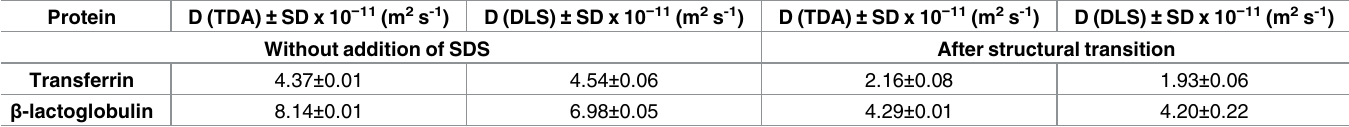
Table 2. Comparison of diffusion coefficients determined using the Taylor dispersion analysis and dynamic light scattering before and after addi- tion of SDS at high concentration to the solution. Protein D (TDA) ± SD x 10 − 11 (m 2 s -1